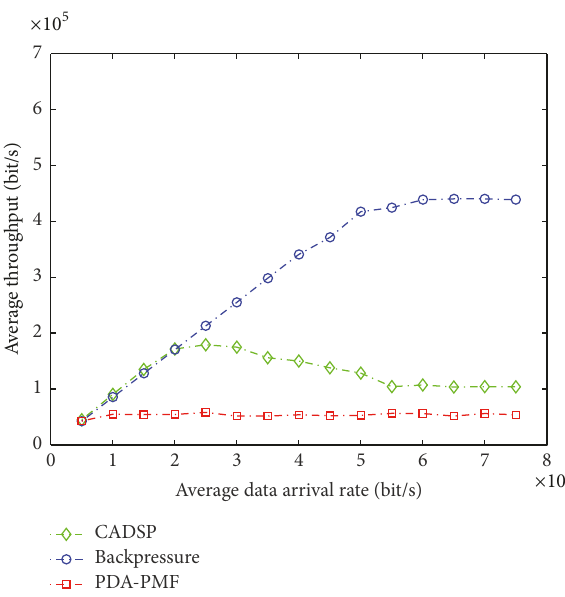
Figure 6: Comparison of average throughput of service 3 in multihop network.